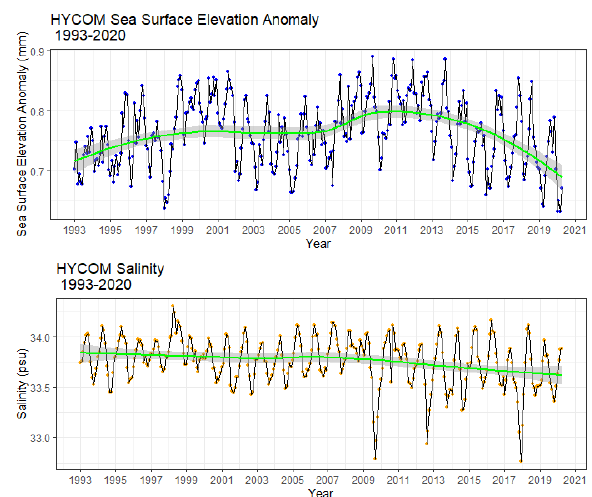
Figure 2. Time series data of the spatial average within the 2km buffer from the land of sea surface temperature, chlorophyll-a concentration, sea surface level anomaly, and salinity extracted from MODIS and HYCOM in Busuanga.